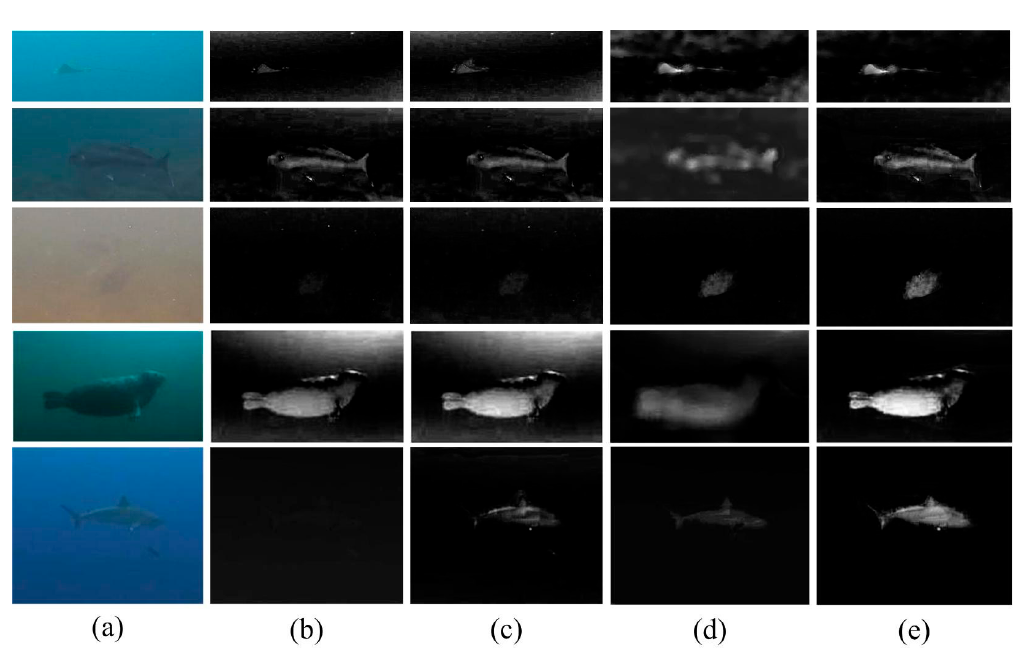
Figure 4. Our ROI detection results. ( a ) Underwater image; ( b ) intensity global contrast; ( c ) color global contrast; ( d ) transmission global contrast; ( e ) ROI detection.